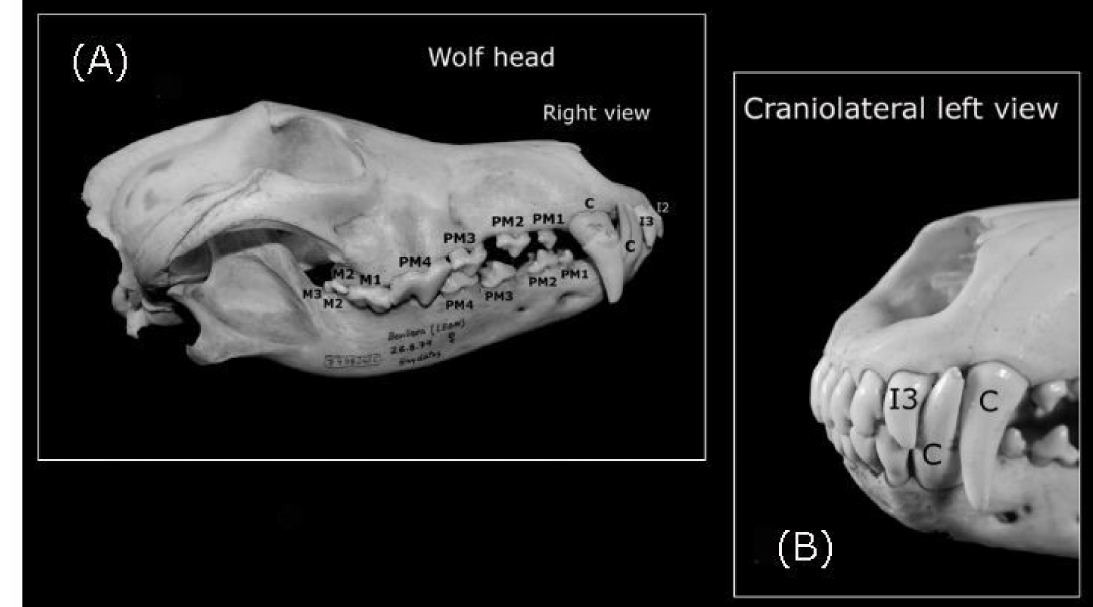
Figure 2. General vision of the Iberian wolf‘s teeth. C: Canine, PM2 and PM3: second and third premolar teeth, respectively; M2 and M3: second and third molar teeth, respectively. ( A ) Wolf skull with the right dental line indicated on the maxillary and mandibular bones; ( B ) Detail of the left-hand canine and I3 on the maxillary and mandibular